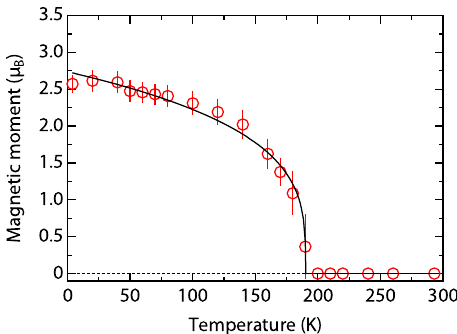
Fig. 5 Temperature dependence of the Mn magnetic moment of Mn 3 RhSi. Error bars were obtained from Rietveld analysis of the neutron diffraction data. The solid line is a power-law fi tting curve, as described in the